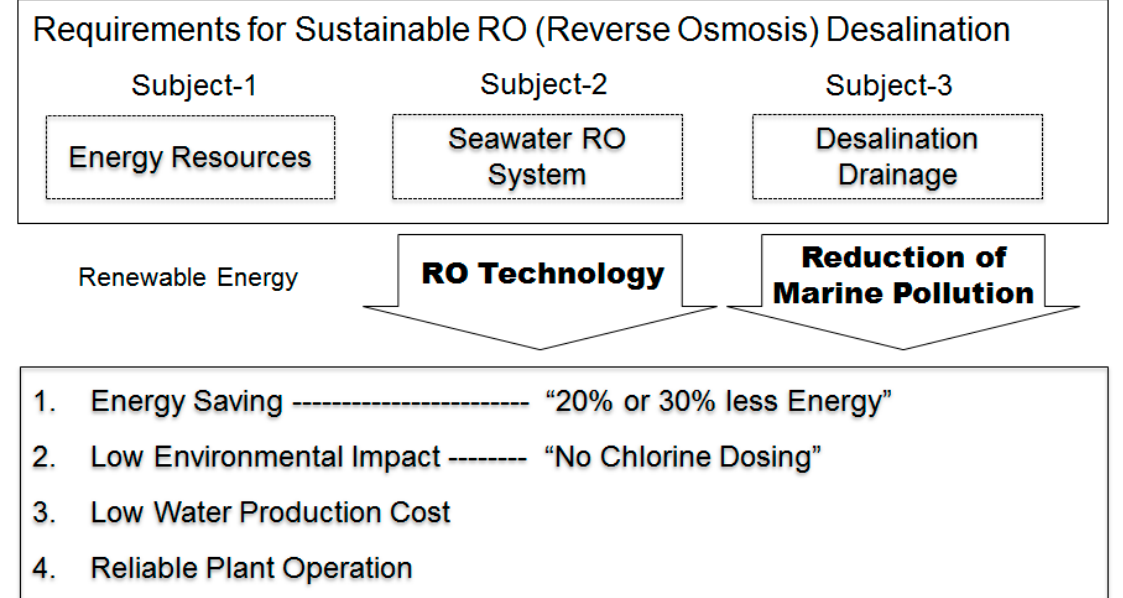
Figure 2. Requirements for sustainable RO (Reverse Osmosis) desalination in the 21st century. Environments 2018 , 5 , x FOR PEER REVIEW